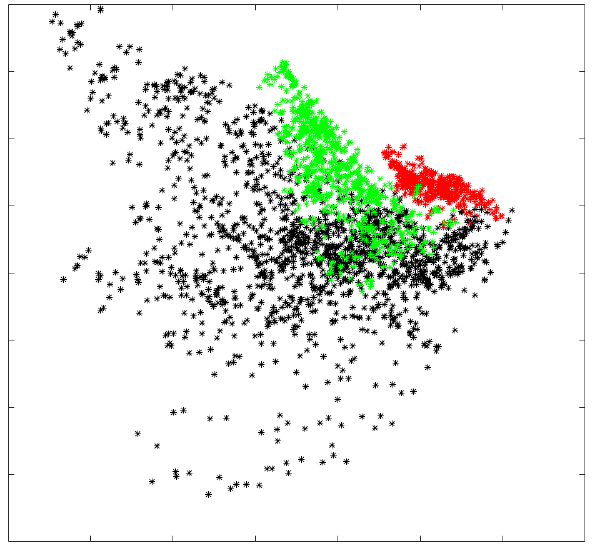
Figure 6. Mapped texture features regarding TerraSAR-X samples of debris (black), vegetation (green) and gravel (red).